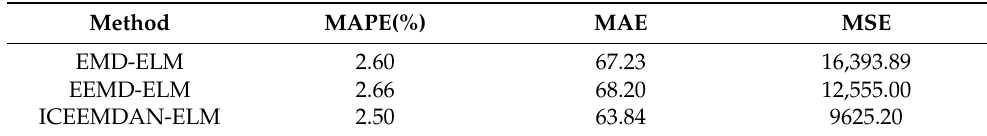
Table 3. Prediction results of ELM.